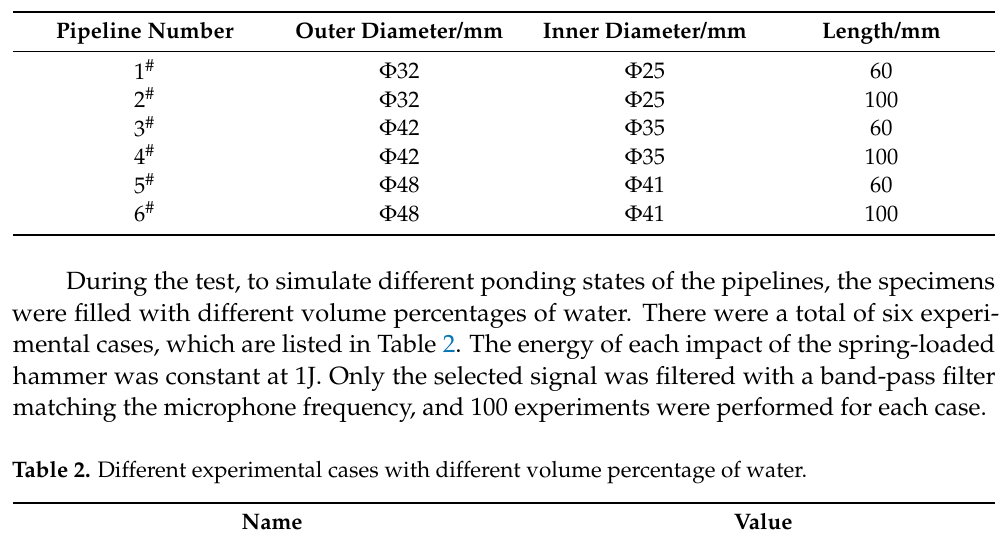
Table 1. Dimensions of the pipeline specimens.